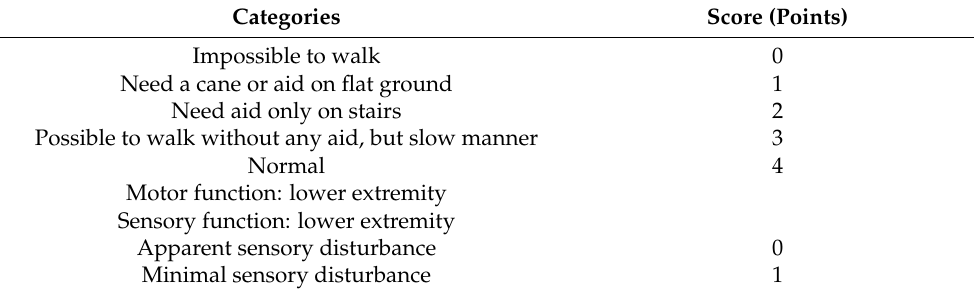
Table 1. Modified Japanese Orthopedic Association (mJOA) scoring system for thoracic